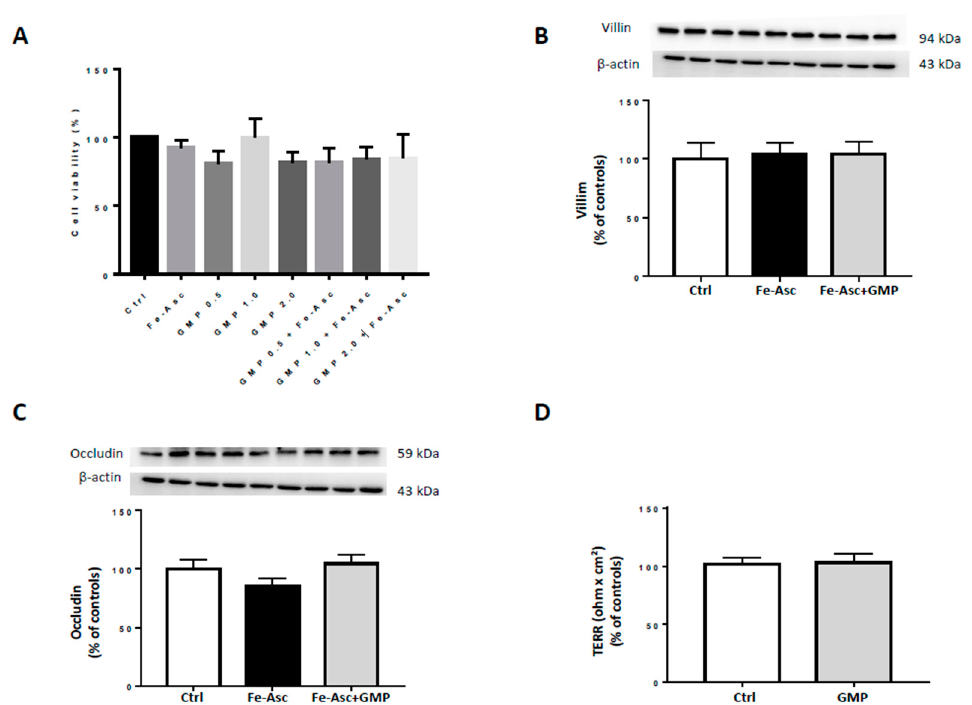
Figure 1. Effects of treatments on cell integrity in Caco-2/15 cells. Integrity of the cell monolayer was evaluated by cell viability, differentiation, and tight junction assays using fully differentiated Caco-2/15 cells. Different doses (0.5, 1, and 2 mg/mL) of purified glycomacropeptide (GMP) powder were added to Caco-2/15 cells 18 h before incubation with Fe/Asc (200 μ M/2 mM) for 6 h at 37 °C for the ( A ) MTT assay. A dose of 2 mg/mL was selected for the assessment of ( B ) villin and ( C ) occludin protein expression as well as ( D ) transepithelial electrical resistance (TEER). Results represent the means ± SEM of n = 3 independent experiments in triplicate.